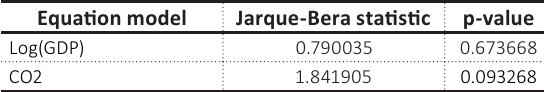
Table 8. Simultaneous significance test results